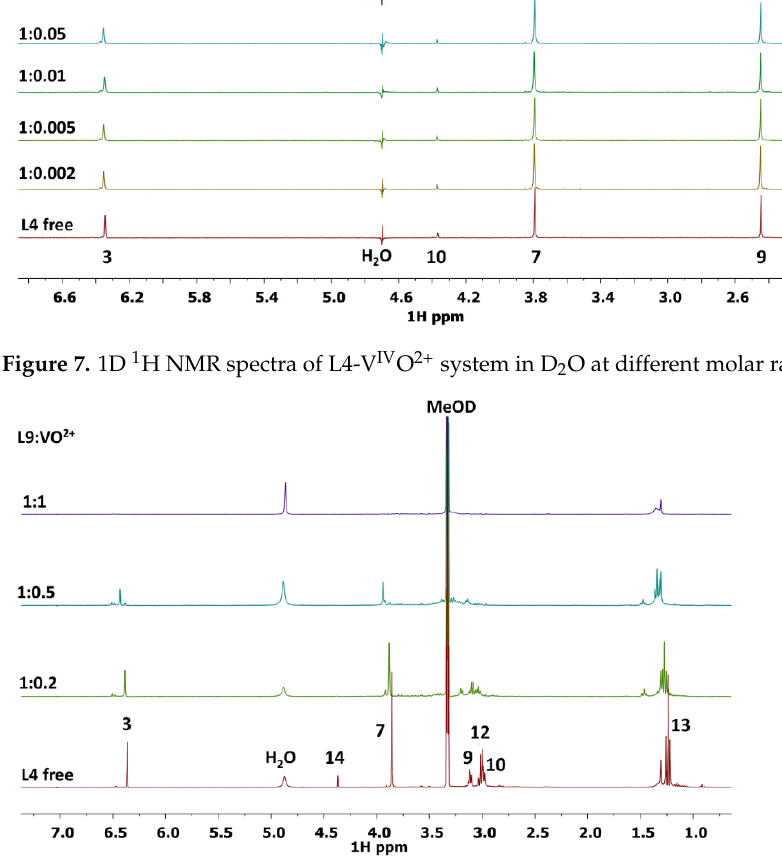
Figure 7. 1D 1 H NMR spectra of L4-V IV O 2+ system in D 2 O at different molar ratios.